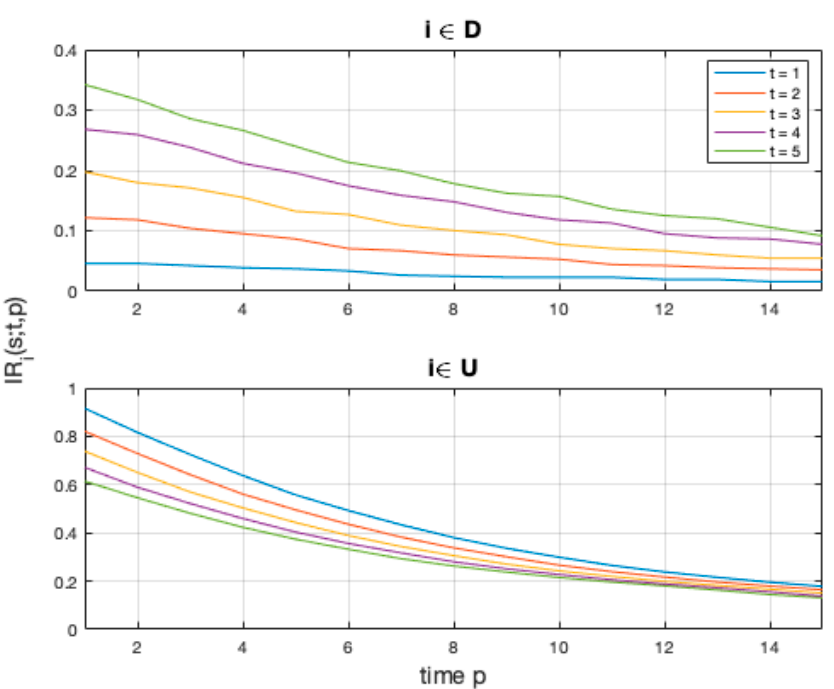
Figure 2. Non-Homogeneous Interval Reliability. For reference purpose we fixed s = 0.